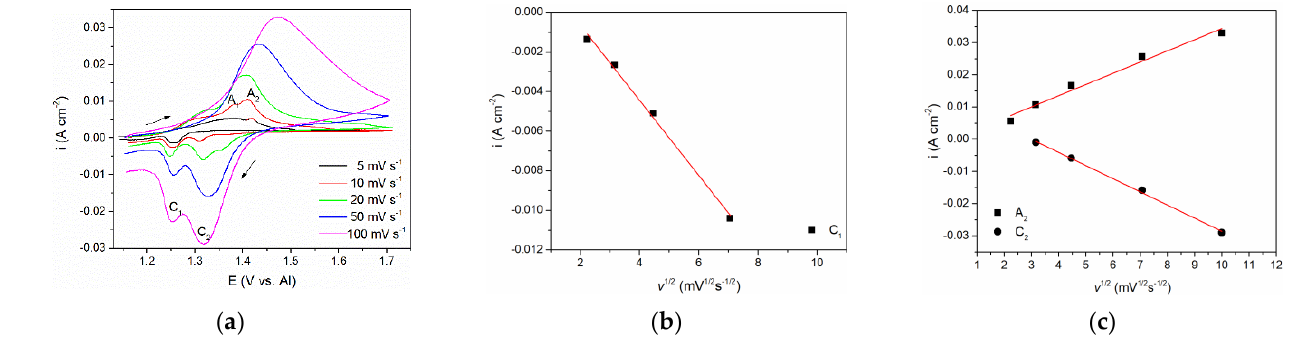
Figure 3. ( a ) Cyclic voltammograms of V WE in equimolar AlCl 3 + NaCl melt, at 200 °C, potential range: E I = 1.100 V to E AF = 1.700 V vs. Al, recorded with different scan rates; ( b ) Plot of C 1 peak current density vs. square root of the scan rates from Figure 3a; ( c ) Plots of A 2 and C 2 peak current density vs. square root of the scan rates from Figure 3a.